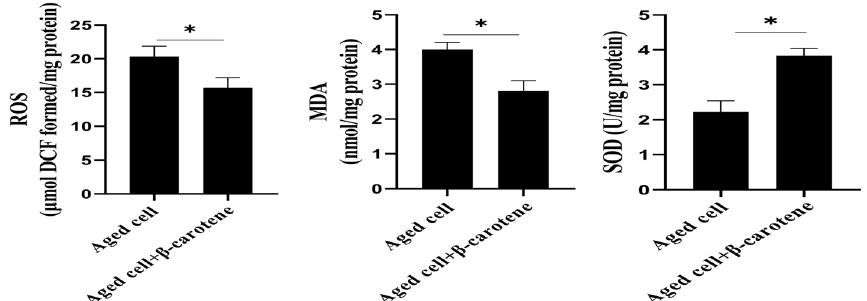
Fig. 8 The effect of β-carotene on oxidative stress. The detailed process of the experiment has been described in the Materials and Methods